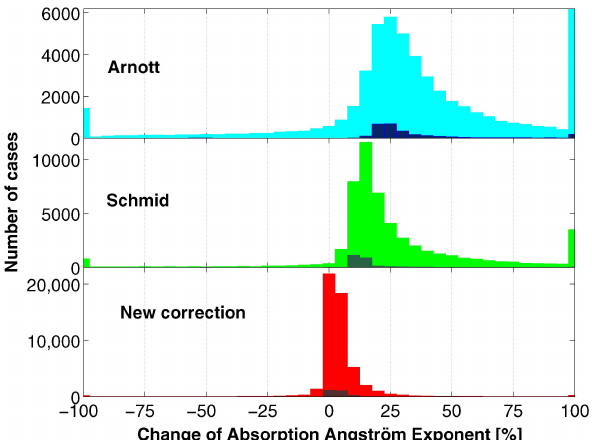
Fig. 8. Monthly regression slopes between the absorption coef- ficients at λ =630nm from the MAAP and the AE (interpolated to λ =630nm) at the four stations for all the different correction schemes as well as between the absorption coefficients given by the MAAP and those measured by the MAAP in transmission only (black dashed line). For all the corrections schemes, the C ref values from Table 4 are applied. The lack of measurements from Septem- ber 2005 to March 2006 at the JFJ is due to a leak in the MAAP